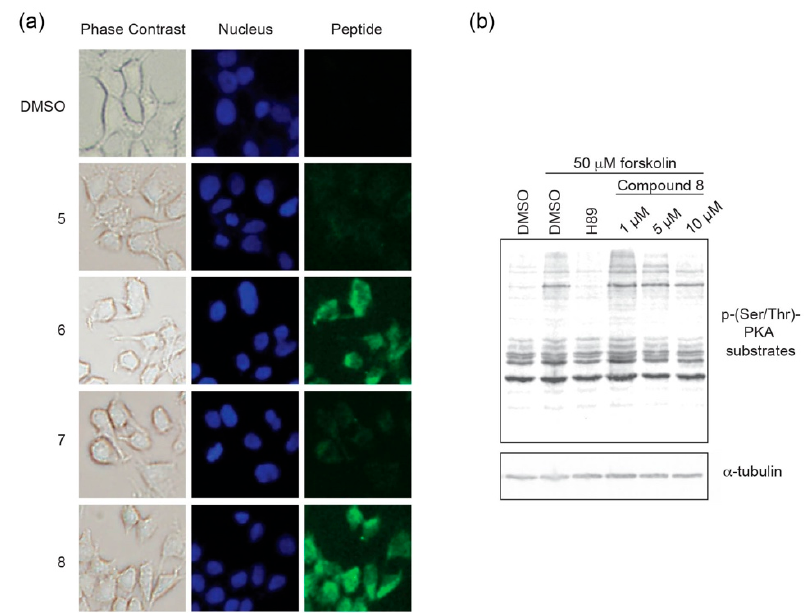
Figure 5. Cell-based uptake and inhibition: ( a ) Cell permeation is detected for stapled compounds 6 and 8 but not their unstapled counterparts after an 8 h incubation period; and ( b ) Cell-based inhibition by monitoring PKA activity in cells. In the presence of 8 , PKA substrate phosphorylation is inhibited in a dose-dependent